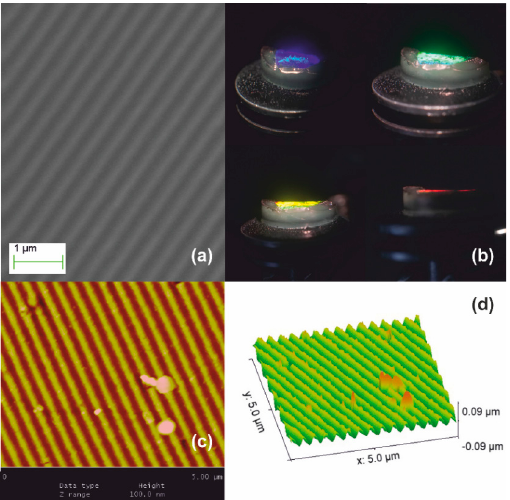
Figure 5. Xerogel Stage II systolic processing: ( a ) SEM micrograph of grating having Λ xero-II ~ 330 nm produced by SF ~1.3× contraction of the sample depicted in Figure 4; ( b ) structural coloration by white light diffraction is visible at oblique angles of incidence; ( c ) AFM image; and ( d ) AFM surface relief presentation.